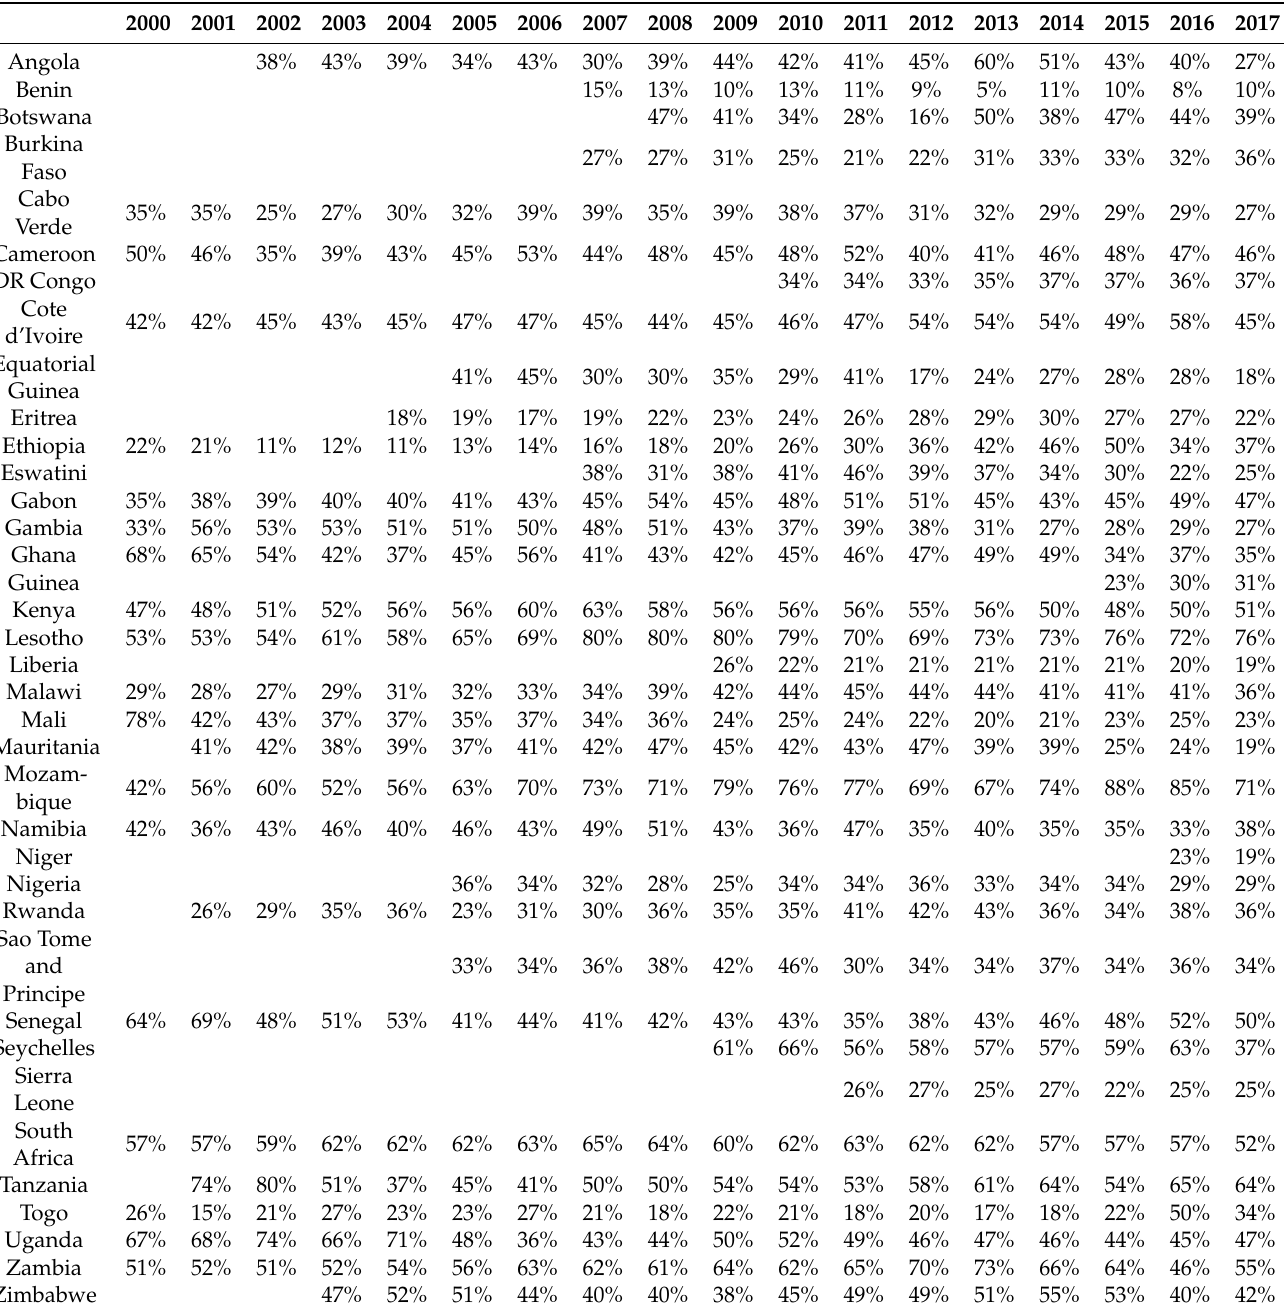
Table A3. Plant load factor of electricity systems of sub-Saharan African countries from 2000 to